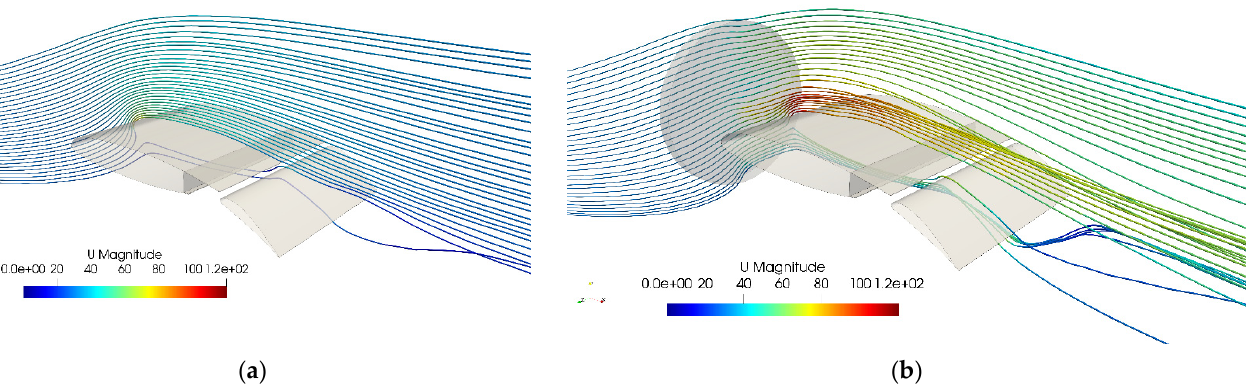
Figure 2. Streamlines on the segment of the flapped wing without ( a ) and with ( b ) propeller-induced velocity.